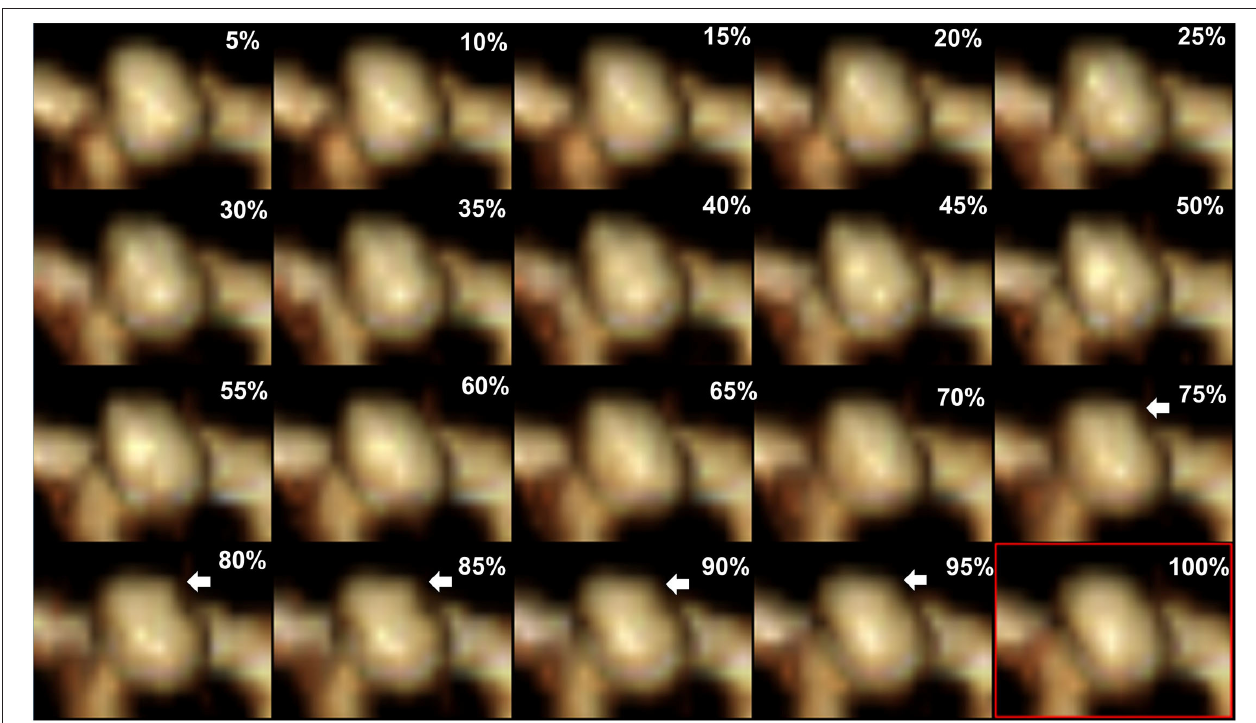
FIGURE 1 | Aneurysm irregular pulsation detected by four-dimensional CT angiography reconstruction. A focal protuberance occurs at the dome of the aneurysm in the 15–19th frames corresponding to the 20 phases in the R-R interval in a single cardiac cycle (white arrow). The protuberance disappears in the 20th frame (red rectangle).